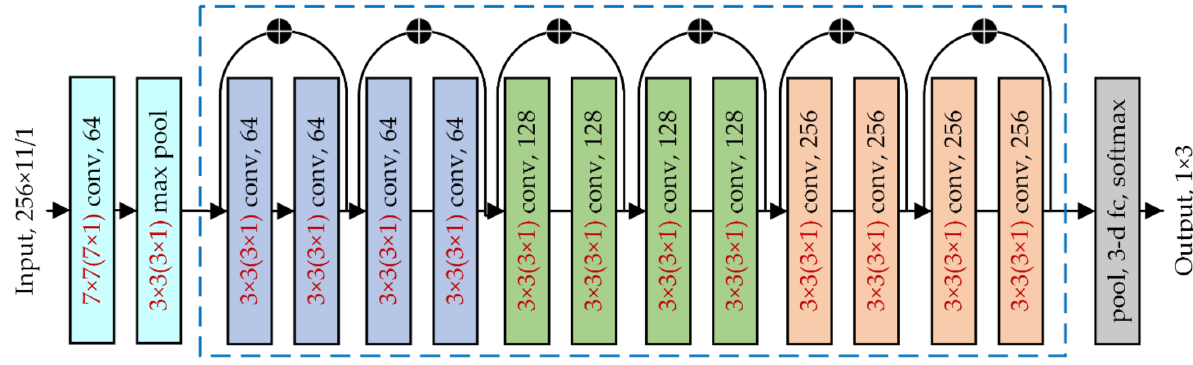
Figure 10. Structure of the deep 1D CNN and 2D